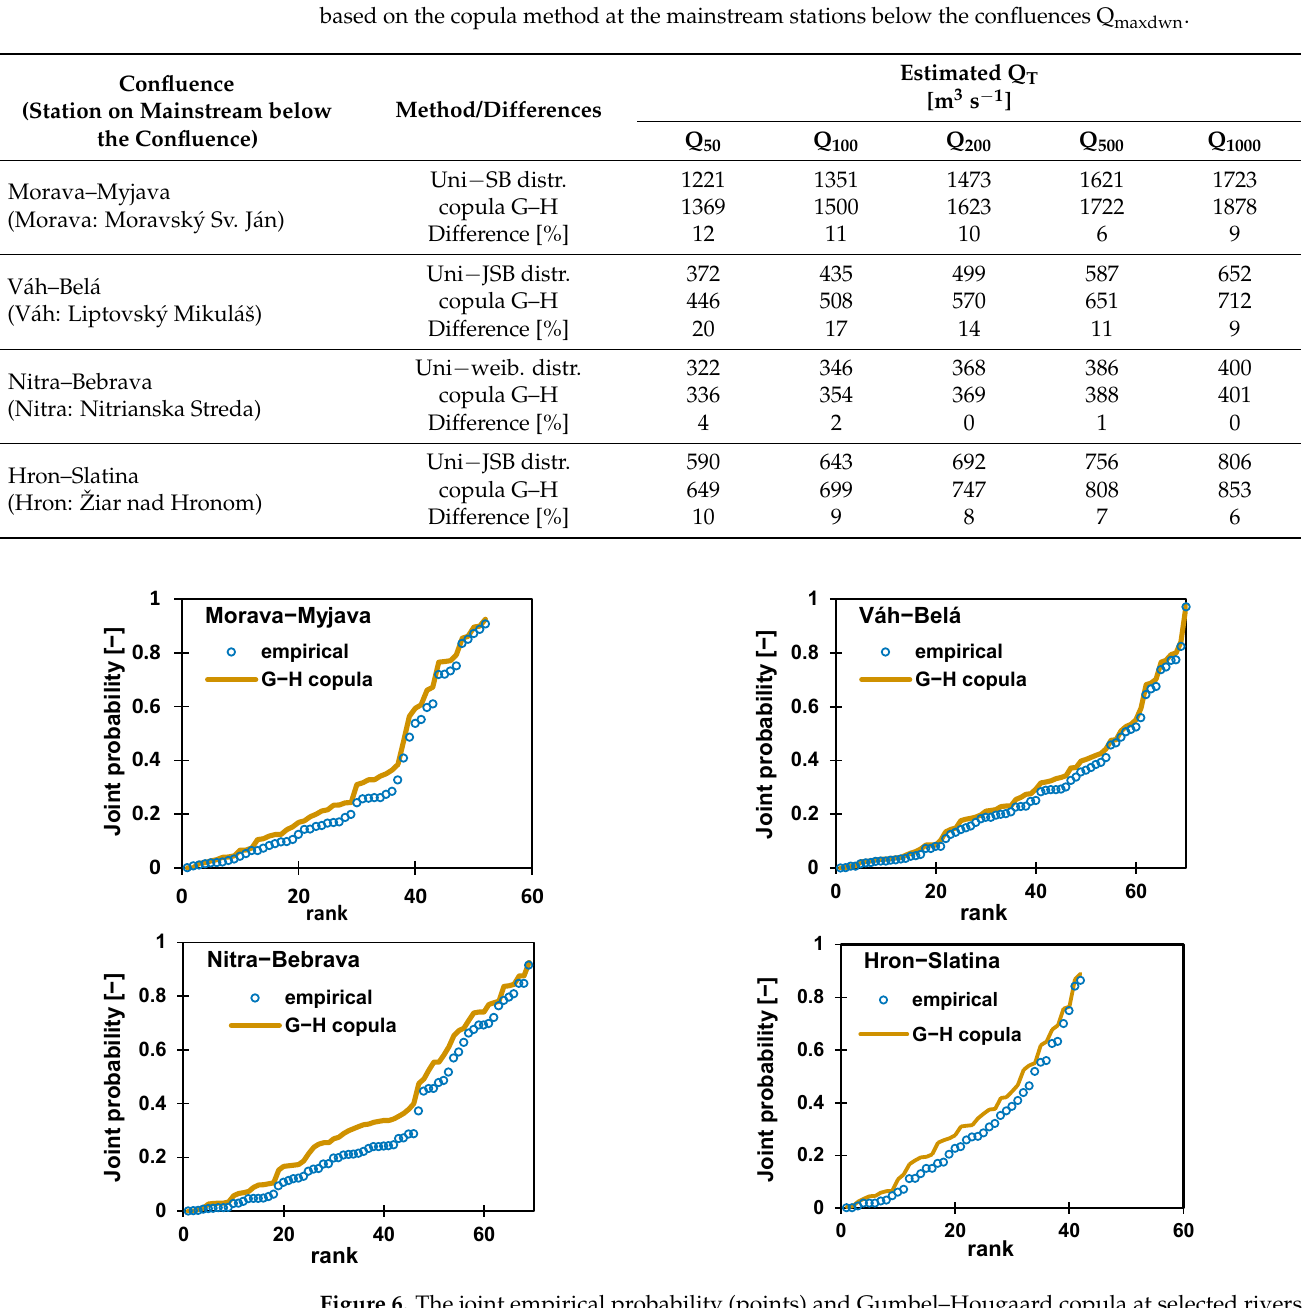
Figure 5. (a) Pearson correlation R of the maximum annual discharges and ( b ) Kendall’s rank correlation τ of the maximum annual discharges.